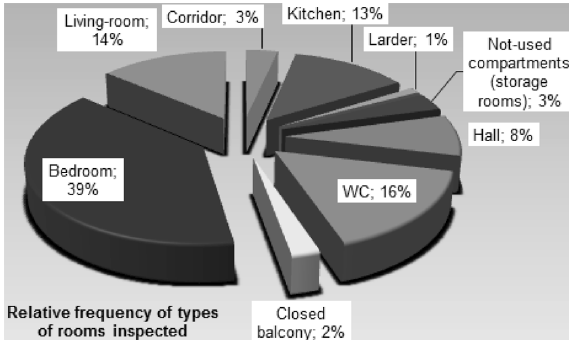
Fig. 2. Relative frequency of types of rooms inspected (Palha et al. 2011)